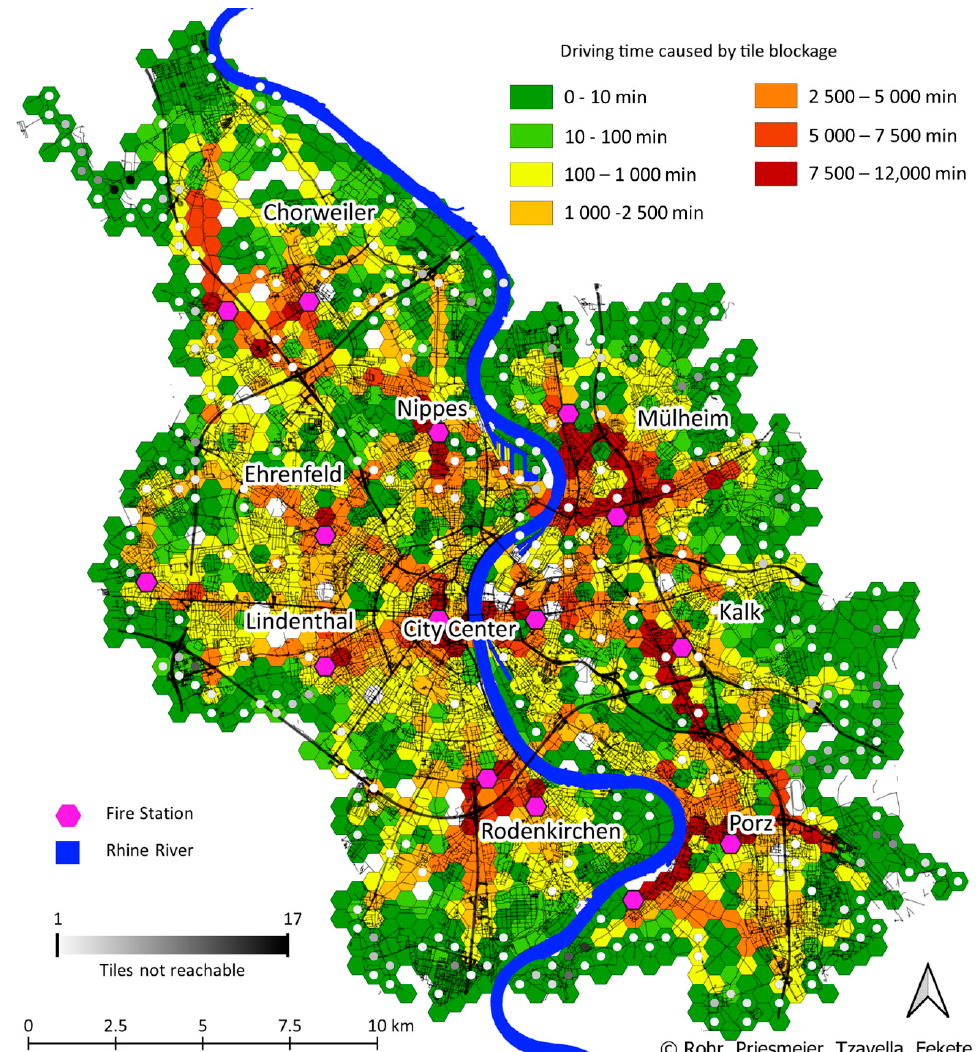
Figure 6. Result of the road network criticality assessment of Cologne (Legend: Green to red = Rising criticality value; violet = fire stations; white to black dots = Rising number of generated “non-reachable” tiles (1–17); black = road